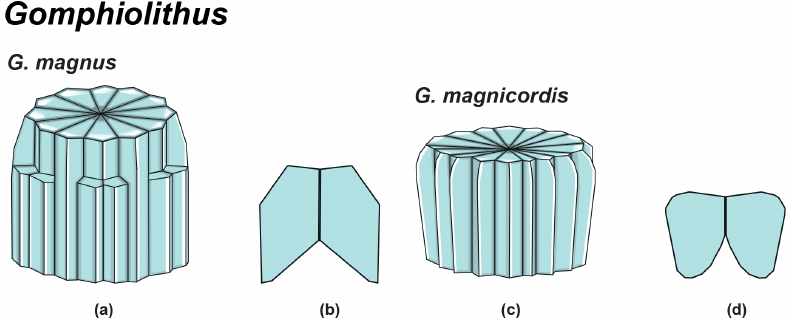
Figure 7. Overview of Gomphiolithus . (a) Schematic drawing of G. magnus showing elongated wedge-shaped elements of different heights forming the column. (b) Schematic cross section of G. magnus . (d) Schematic drawing of G. magnicordis with elongated wedge-shaped elements of the same length forming the column. (g) Schematic cross section of G. magnicordis